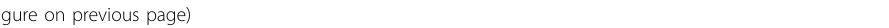
Fig. 6 TSCs transplantation improves oocyte development and quality. a Statistics on the number of oocytes obtained for superovulation after TSCs transplantation. b Phase-contrast micrographs of oocytes in different groups. The green arrow represents MII, the blue arrow represents MI, and the yellow arrow represents GV. The number of oocytes obtained after COS. c Statistics on the maturation percentage of oocytes obtained for superovulation after TSCs transplantation. d The quality of eggs was observed by immuno fl uorescence staining with an anti-cleaved caspase3, TOM-20, and ROS in the oocytes. e Statistics analysis of cleaved caspase3 fl uorescence indicating oocytes apoptosis, the density of fl uorescence represents the level of apoptosis. f The richness of mitochondria in oocytes was observed by immuno fl uorescence staining with an anti-TOM20, and the density of fl uorescence represents the number of mitochondria. g Statistics analysis of the oxygenation of the oocytes were observed by immuno fl uorescence staining with an anti-ROS probe, and the density of fl uorescence represents the level of ROS. h Chromosomal behavior (anti- β -tubulin and DAPI). i Statistics analysis of the chromosomal behavior in the oocytes. j The percentage of the oocyte fertilization after ICSI in vitro. k The percentage of the blastocyst of the embryo after ICSI in vitro. The CON group represents the normal wild type monkeys ( n = 3), the POI group represents the monkeys with premature ovarian failure ( n = 3), the ADSCs group represents the monkeys with POI that received adipose-derived mesenchymal stem cells transplantation (ADSCs = POI + ADSCs, n = 3); the TSCs group represents the monkeys with POI that received thecal stem cells transplantation (TSCs = POI + TSCs, n = 3). Data were expressed as the means ± SEM and signi fi cance were determined by one-way ANOVA. * P < 0.05, ** P < 0.01, ns not signi fi